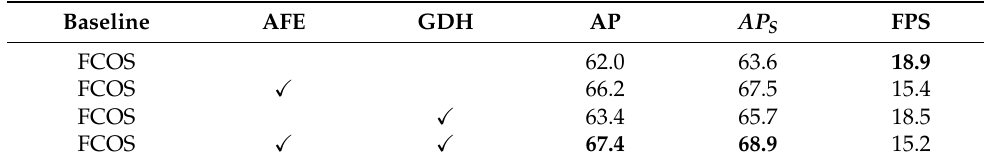
Table 9. Experimental results of the two module on HRSID.